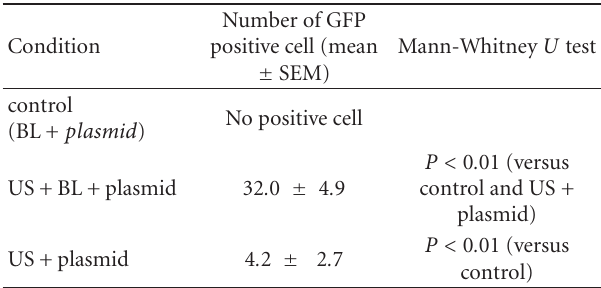
Table 1: Quantification of gene-transfer e ffi ciency by counting the number of GFP-positive